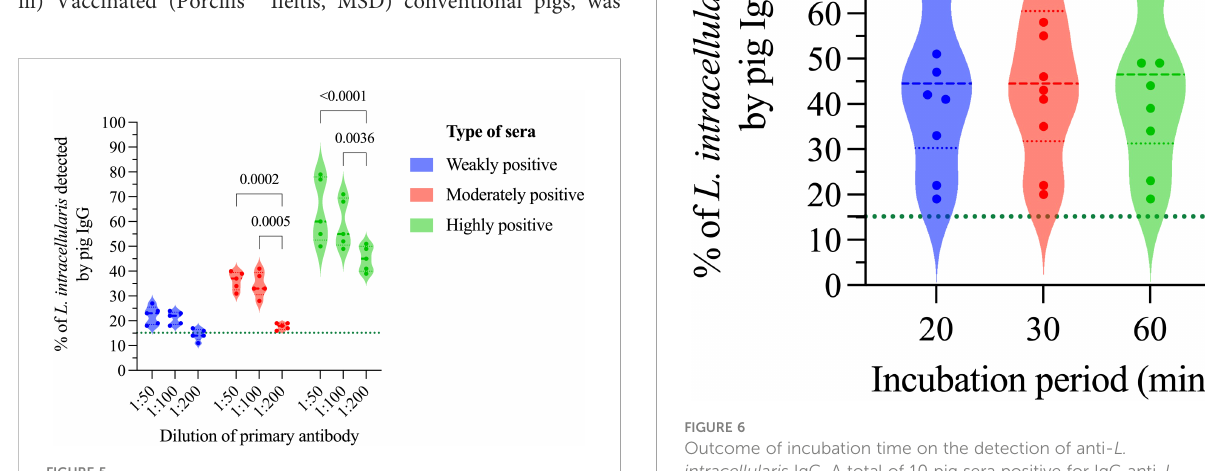
FIGURE 6 Outcome of incubation time on the detection of anti- L. intracellularis IgG. A total of 10 pig sera positive for IgG anti- L. intracellularis were included in this analysis. Pig sera were incubated for 20, 30 and 60 minutes with 10 6 L. intracellularis at 37°C. Subsequently, the samples were incubated with the secondary antibody for the same times. Statistical comparison was performed using one-way ANOVA with Tukey ’ s multiple comparisons. No statistical differences (ns) were observed between the different times